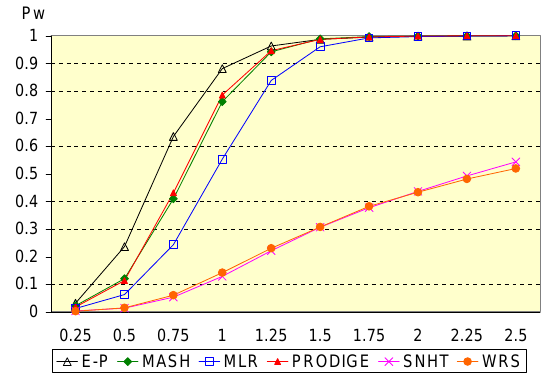
Figure 4. Power of detection for the largest IH of Fig. 3. On the abscissa the unit is s d .